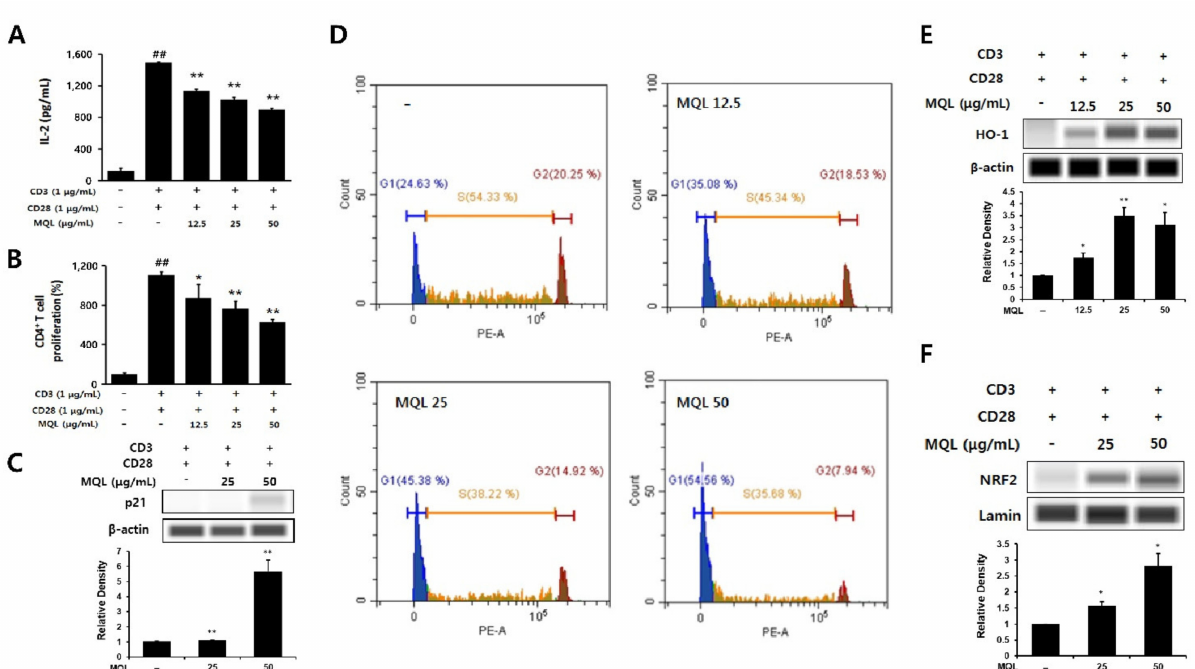
Figure 3. Effects of MQL on CD4 + T cell proliferation and HO-1 expression. CD4 + T cells (1 × 10 6 cells/mL) isolated from splenocytes were seeded and cultured with anti-CD3 (1 µ g/mL) and anti-CD28 antibodies (1 µ g/mL). CD4 + T cells were cultured in the presence or absence of MQL for 48 h. ( A ) IL-2 in culture supernatant of CD4 + T cells was measured using ELISA. ( B ) CD4 + T cell proliferation was measured using MTT assay. ( C ) Expression of p21 was detected using Western blot, and ( D ) cell cycle of CD4 + T cells was measured using flow cytometry. ( E ) HO-1 expression and ( F ) NRF2 nuclear translocation were detected in CD4 + T cell cultured in the presence or absence of MQL using Western blot. Results are shown as mean ± SD. ## p < 0.01, between the non-stimulated and CD3/28-stimulated groups, * p < 0.05, ** p < 0.01, between the MQL-treated and CD3/28-stimulated